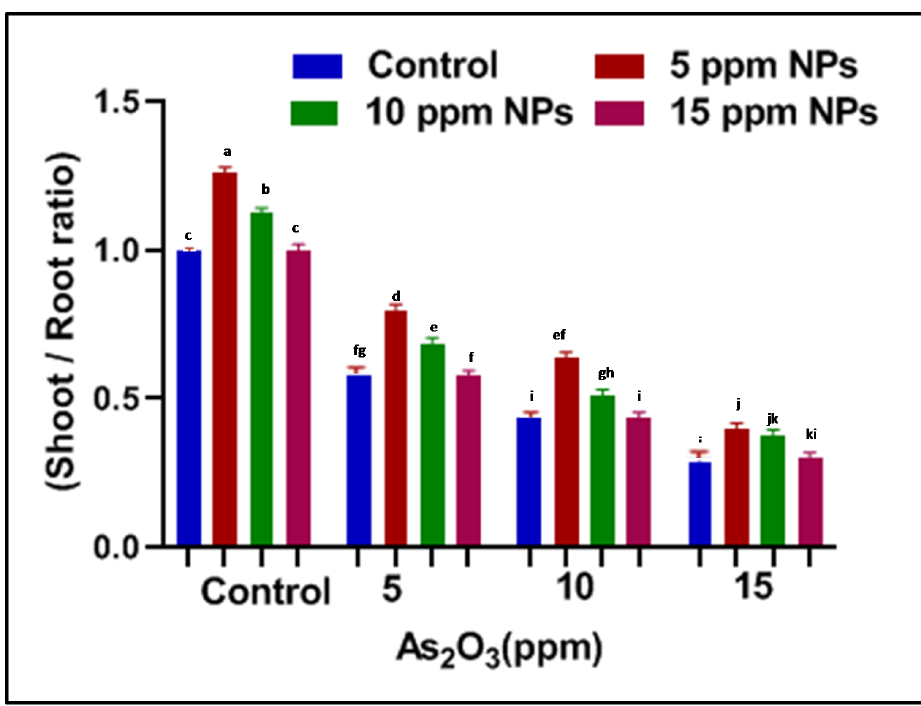
Figure 5. Effect of Bacillus subtilis -synthesized Fe 3 O 4 NPs on shoot/root ratio of rice ( Oryza sativa L.) in arsenic-contaminated water. Different letters show a significant difference at p < 0.05 between treatments.